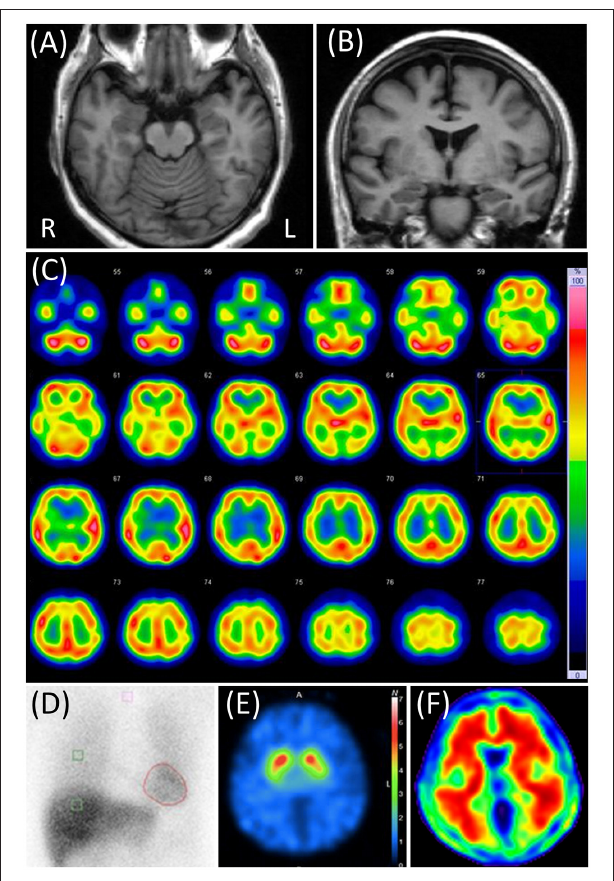
FIGURE 1 | Case 1 images. (A,B) Brain magnetic resonance T1-weighted images. None of them showed any abnormalities. (C) N-isopropyl-p-[123I] iodoamphetamine (123I-IMP) single-photon emission computed tomography (SPECT) not showing any particular abnormalities. (D) Cardiac [123I]-metaiodobenzylguanidine scintigraphy. Heart-to-mediastinum ratios were 3.33 and 2.28 in early and delayed phases, respectively. The washout ratio was 48.8%. (E) 2 β -carbometoxy-3 β -(4-iodophenyl)-N-(3-fluoropropyl) nortropane (FP-CIT) SPECT. The specific binding ratios were 6.53 and 6.04 in